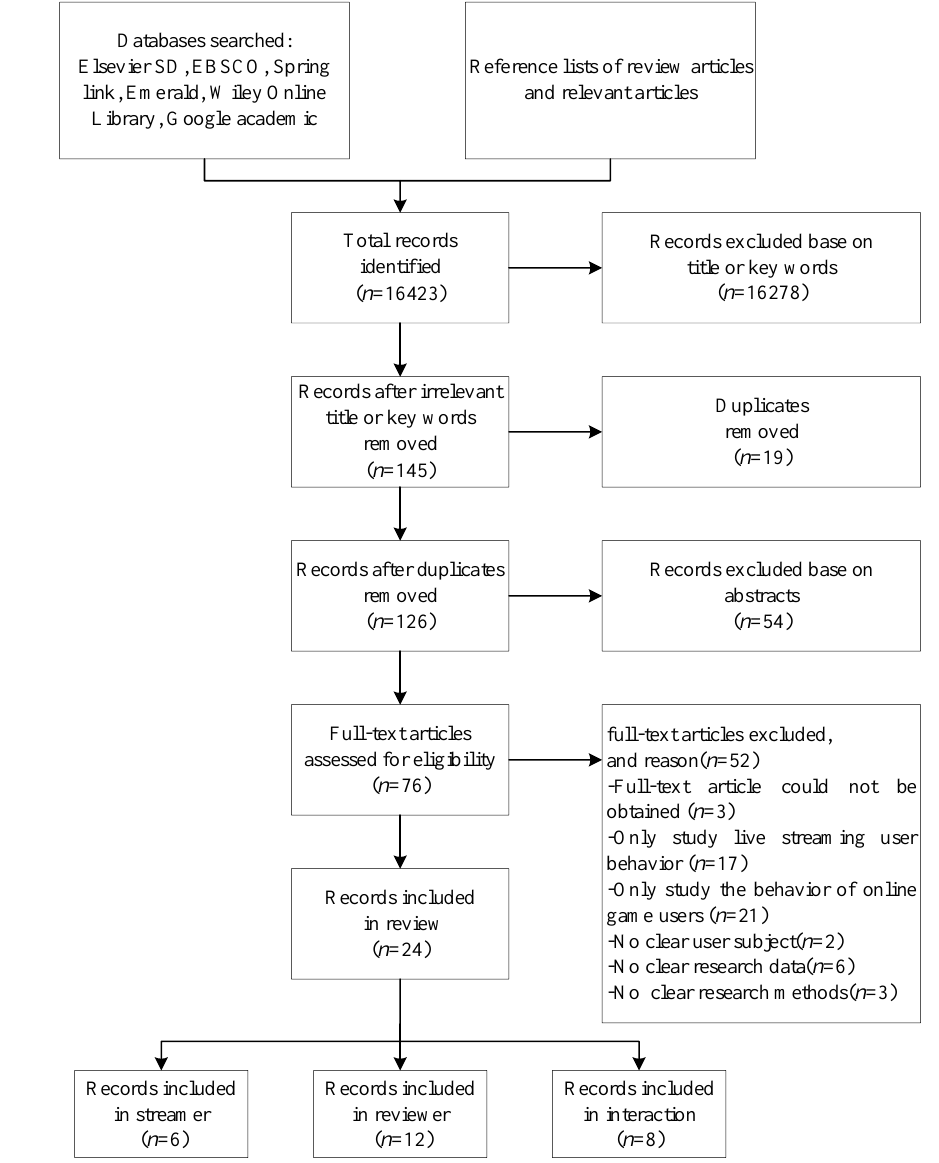
Figure 1. Flowchart of the systematic review process. Note: There were two instances in which the same paper was included for both records for the audiences and records for interaction. same paper was included for both records for the audiences and records for